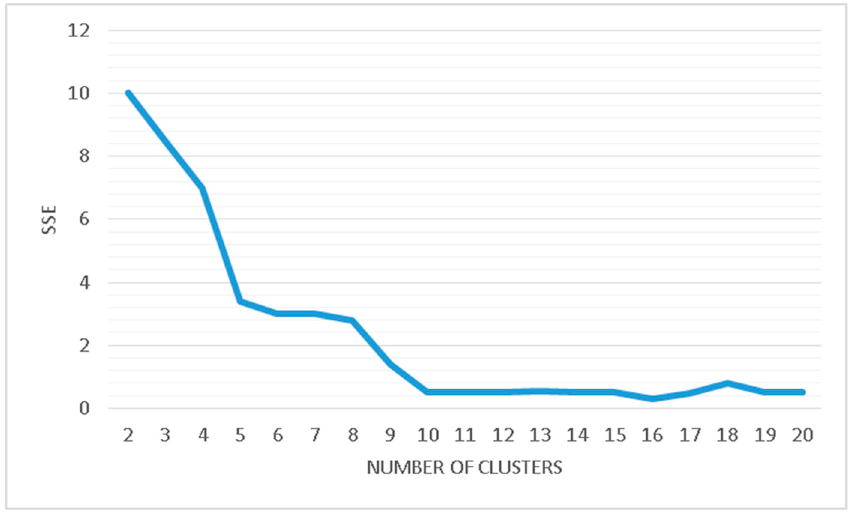
Figure 13. Sum of squared error (SSE) versus number of clusters.